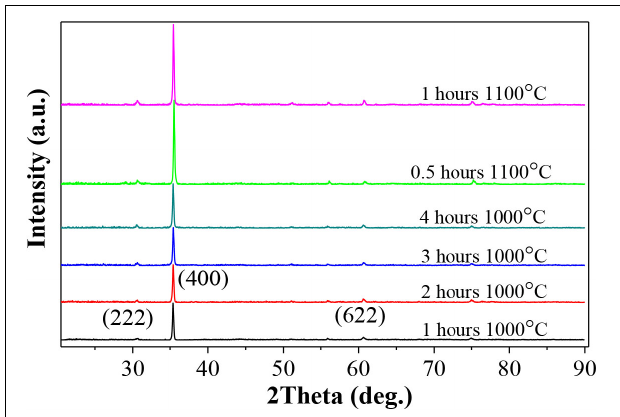
FIGURE 4 | XRD patterns of the ITO films deposited onto LGS substrates, annealed for different dwell times.